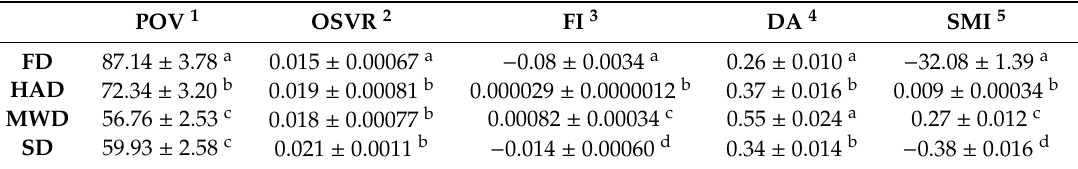
Table 1. Microtomographic parameters of the fruit bodies of Pleurotus ostreatus , dried in various ways. POV 1 POV